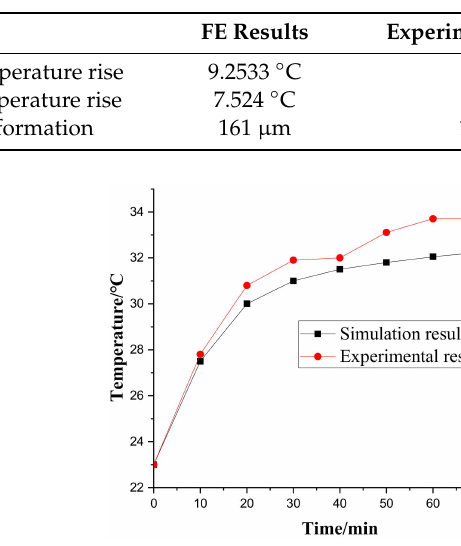
Table 3. Comparison of experimental and FE results.